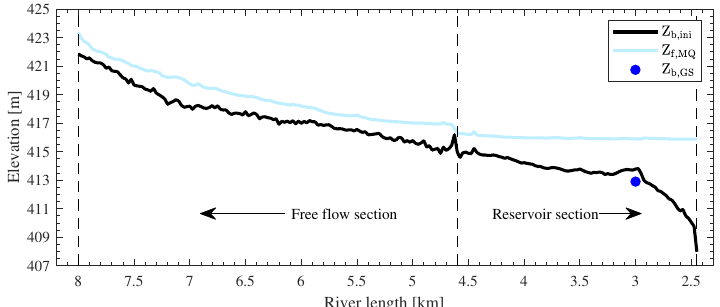
Figure 5. Longitudinal section of the initial bathymetry of the Saalach River, representing the maximum acceptable riverbed in the reservoir Z b,ini ( black ), the water surface level Z f,MQ ( light blue ) during normal mean discharge conditions, and the top edge of the ground sill Z b,GS at x =